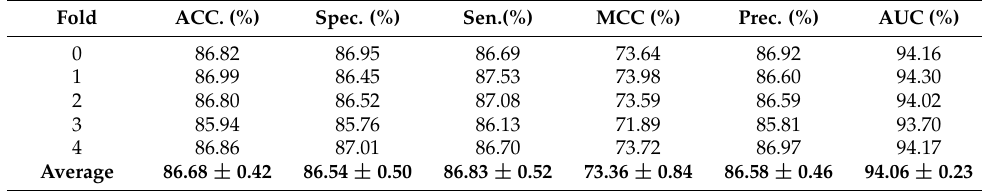
Table 1. The detailed prediction performance of SMMDA.